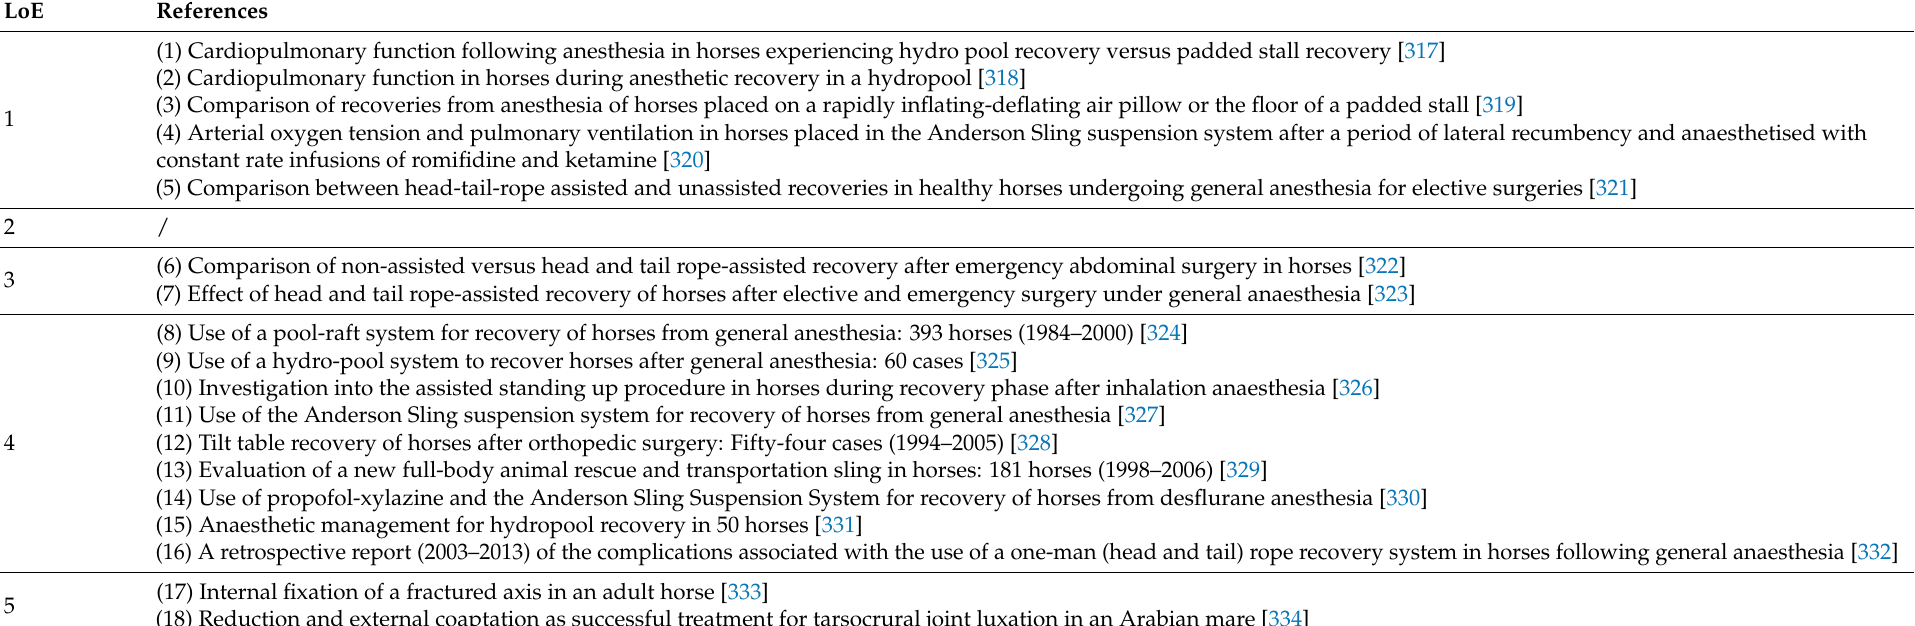
Table 9. Total of publications giving information about “ recovery systems